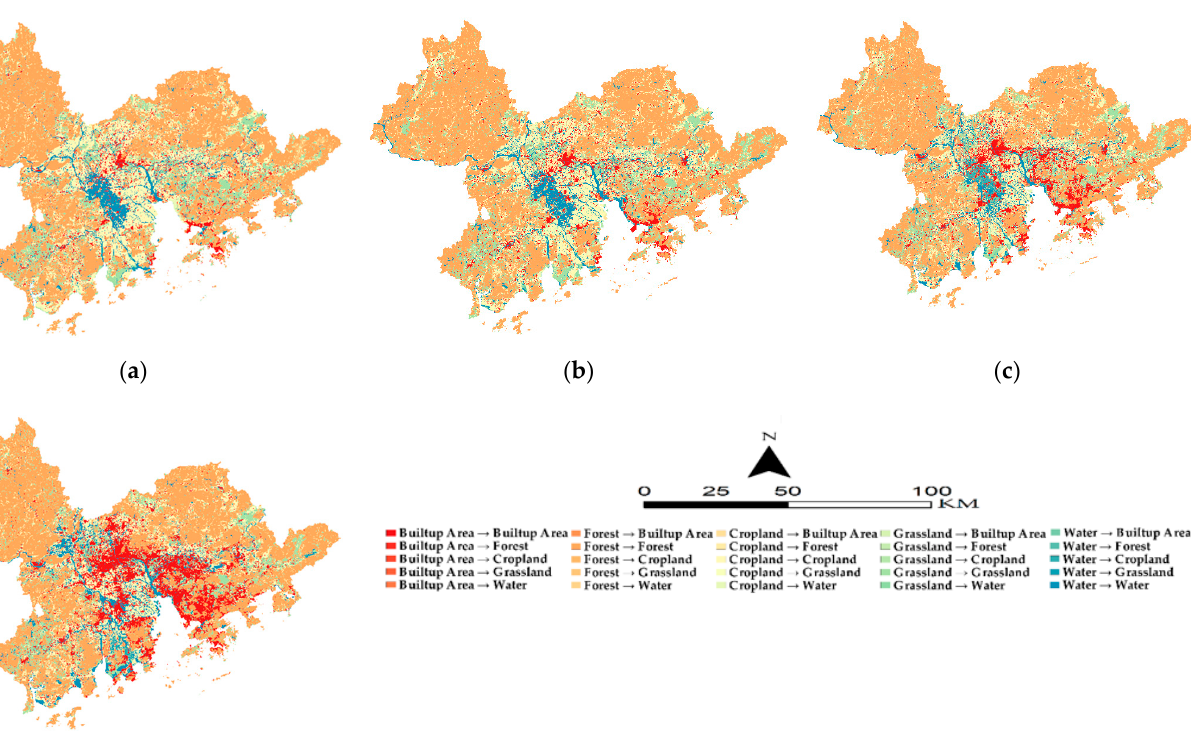
Figure 4 . Change maps ( a ) 1980–1990, ( b ) 1990–2000, ( c ) 2000–2010, and ( d ) 2010–2020. Figure 4. Change maps ( a ) 1980–1990, ( b ) 1990–2000, ( c ) 2000–2010, and ( d )